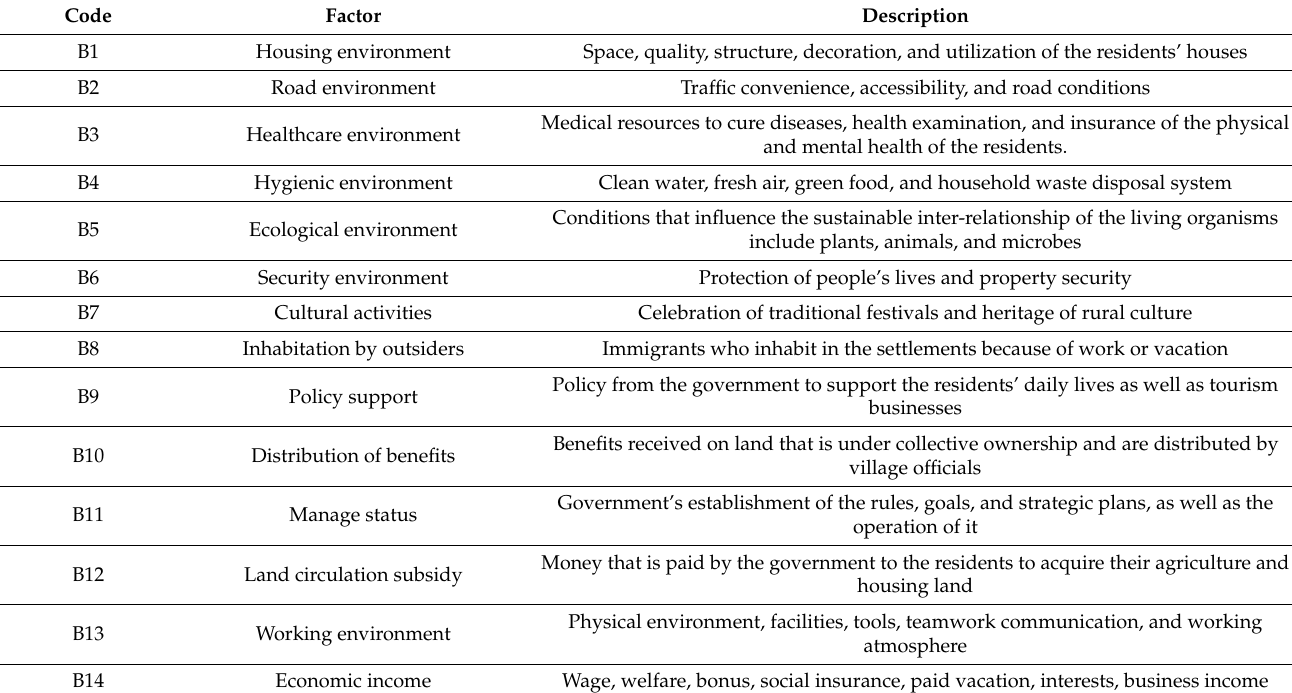
Table 1. Description of 14